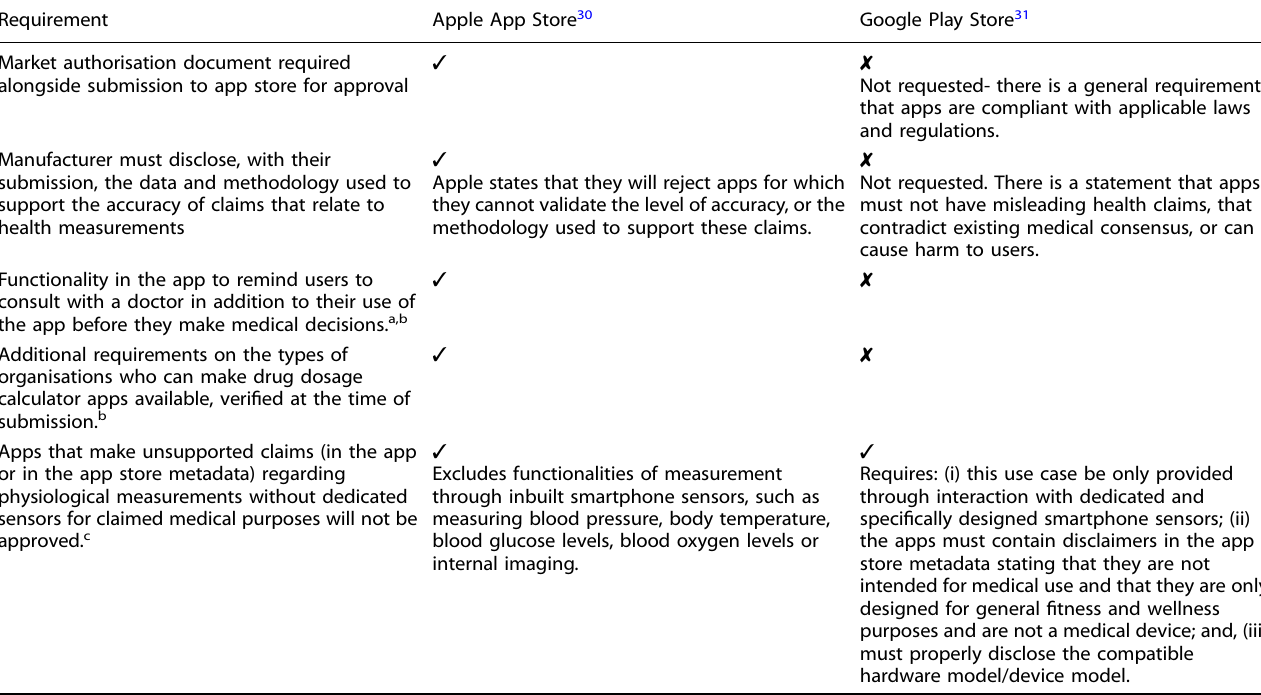
Table 2. App store requirements for developers of health apps that do not apply to non-health